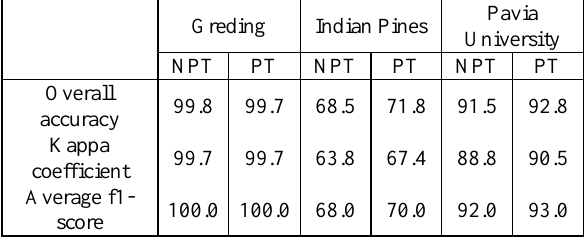
Table 4. Classification metrics for the three airborne hyperspectral datasets. NPT refers to the n on- p re- t rained classification model, while PT denotes the p re- t rained